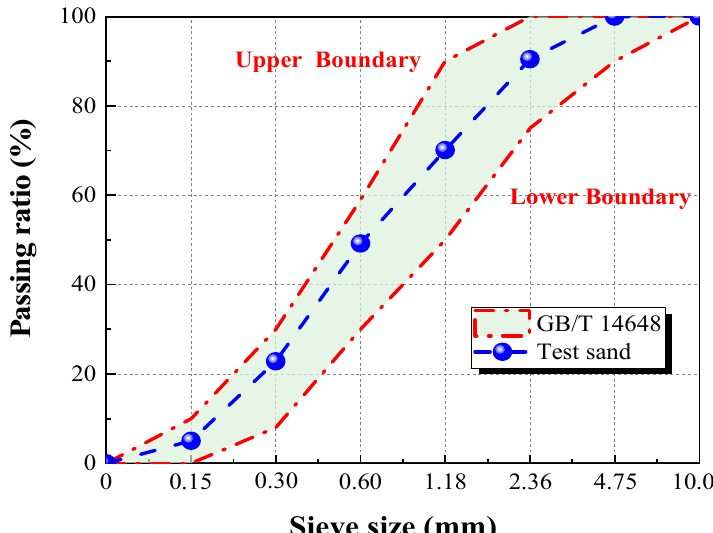
Figure 1. Gradation cure of sand.